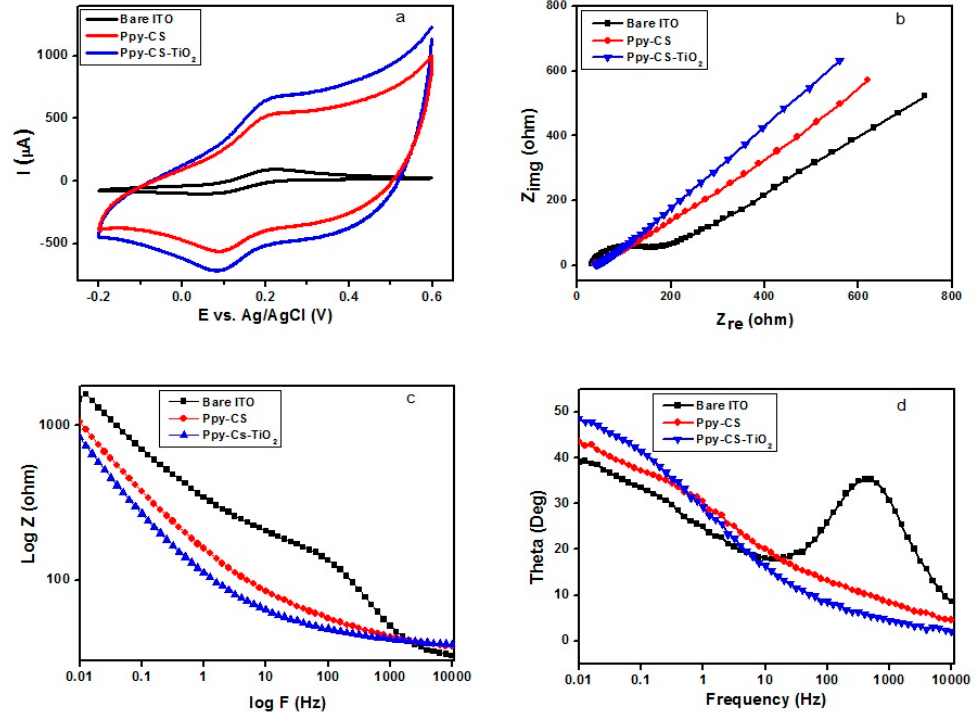
Figure 4. ( a ) Cyclic voltammograms obtained for bare ITO, Ppy-CS composite, and Ppy-CS-TiO 2 nanocomposites; ( b ) Nyquist plots; ( c ) Bode impedance phase plots of log z; ( d ) Bode phase plots for 1 mM K 3 [Fe(CN) 6 ] in 0.1 M KCl at a scan rate of 50 mV·s − 1 vs. (Ag/AgCl).